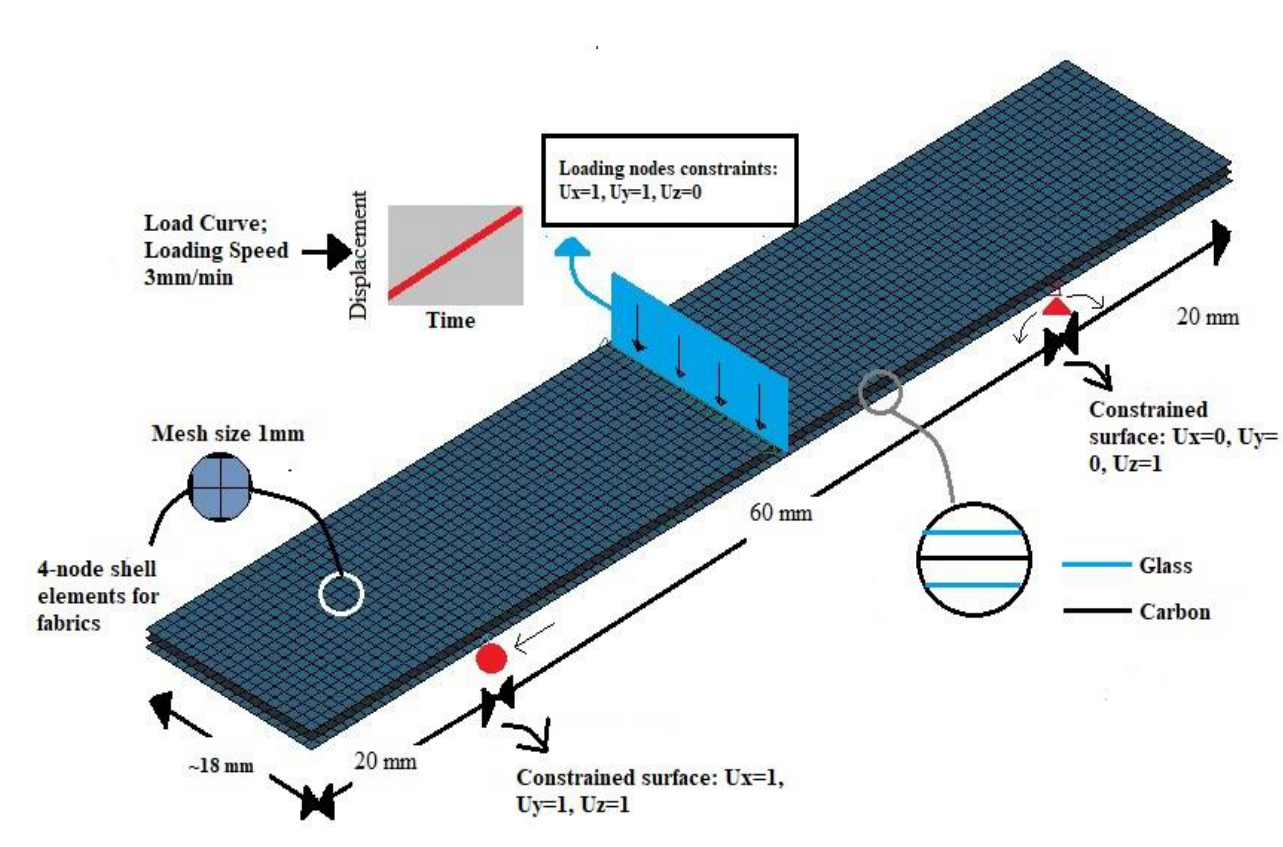
Figure 2. FEM schematic of the specimens, including modelling, materials, meshing, constraints, contact definition, and loading conditions. Table 3. Composite specimen properties for numerical modelling. X T : strength in tension (longitudi- nal); X C : strength in compression (longitudinal); Y T : strength in tension (transverse); Y C : strength in compression (transverse); S L : shear strength.